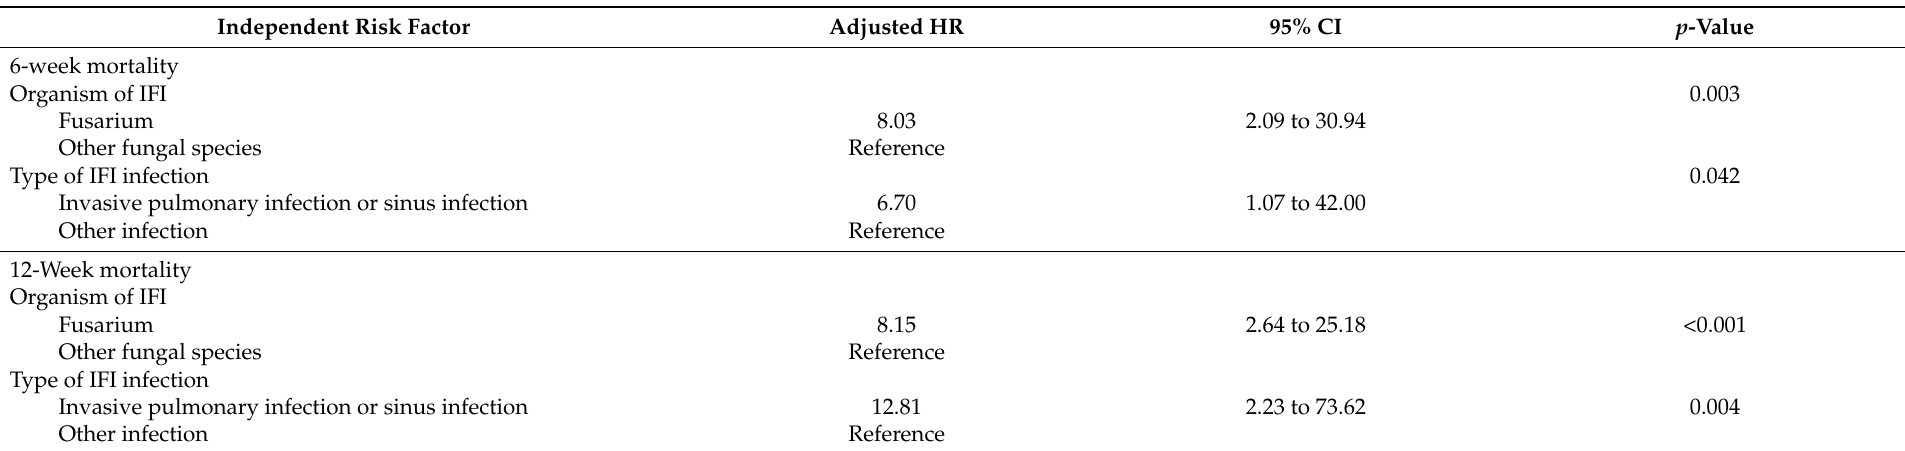
Table 5. Multivariable Cox regression analysis of risk factors for